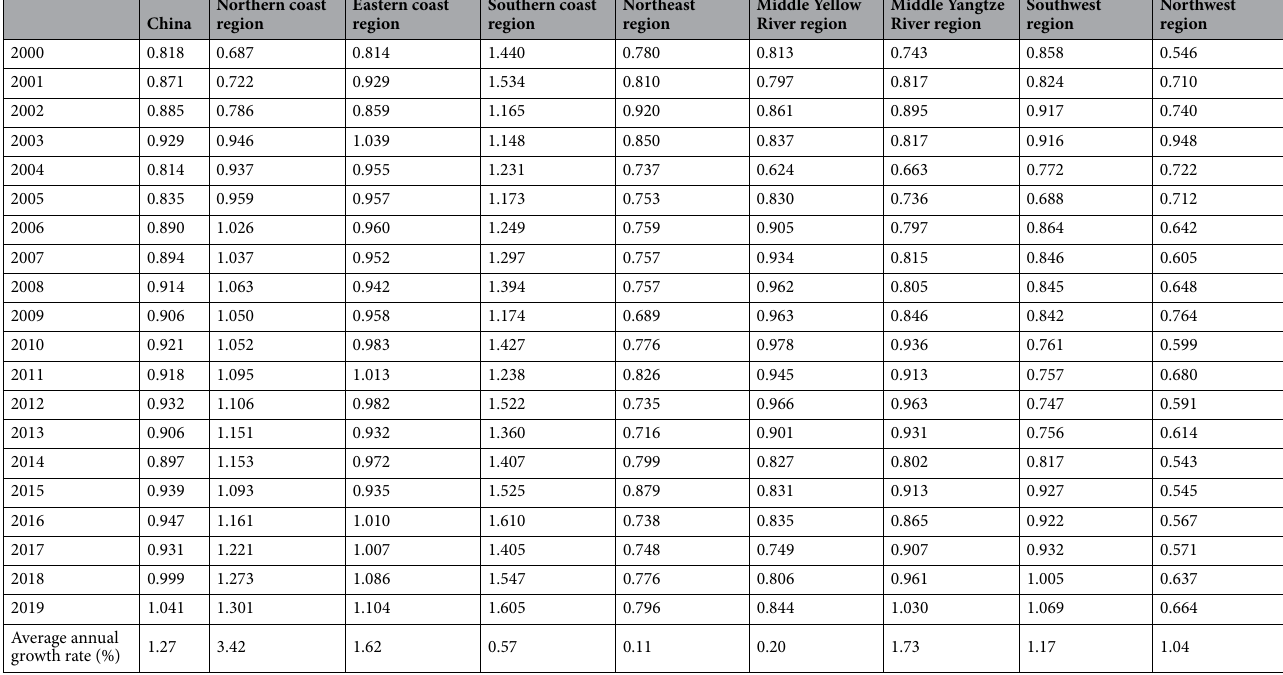
Table 3. The averages of CEEIE of China and the eight regions from 2000 to 2019.